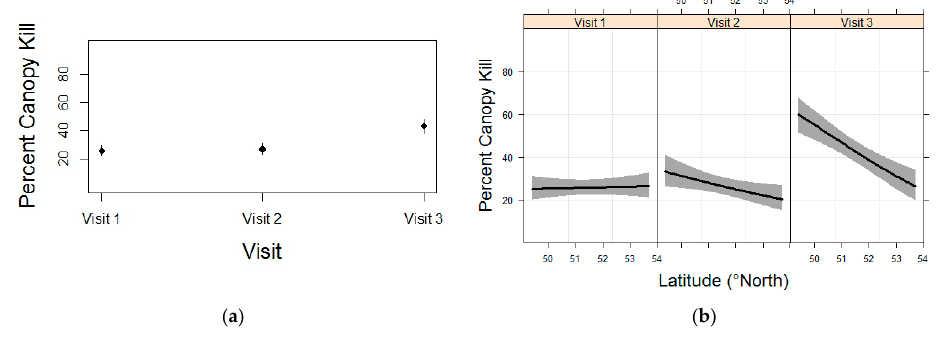
Figure 6. Fitted estimates of canopy kill by all causes as a function of visit ( a ) and latitude by year ( b ) from the optimal tree mortality model. Plots were constructed using the range of values for visit ( a ) and latitude by year ( b ) while holding remaining predictor variables at their mean values for the study area. Confidence intervals (alpha = 0.05) are shown.